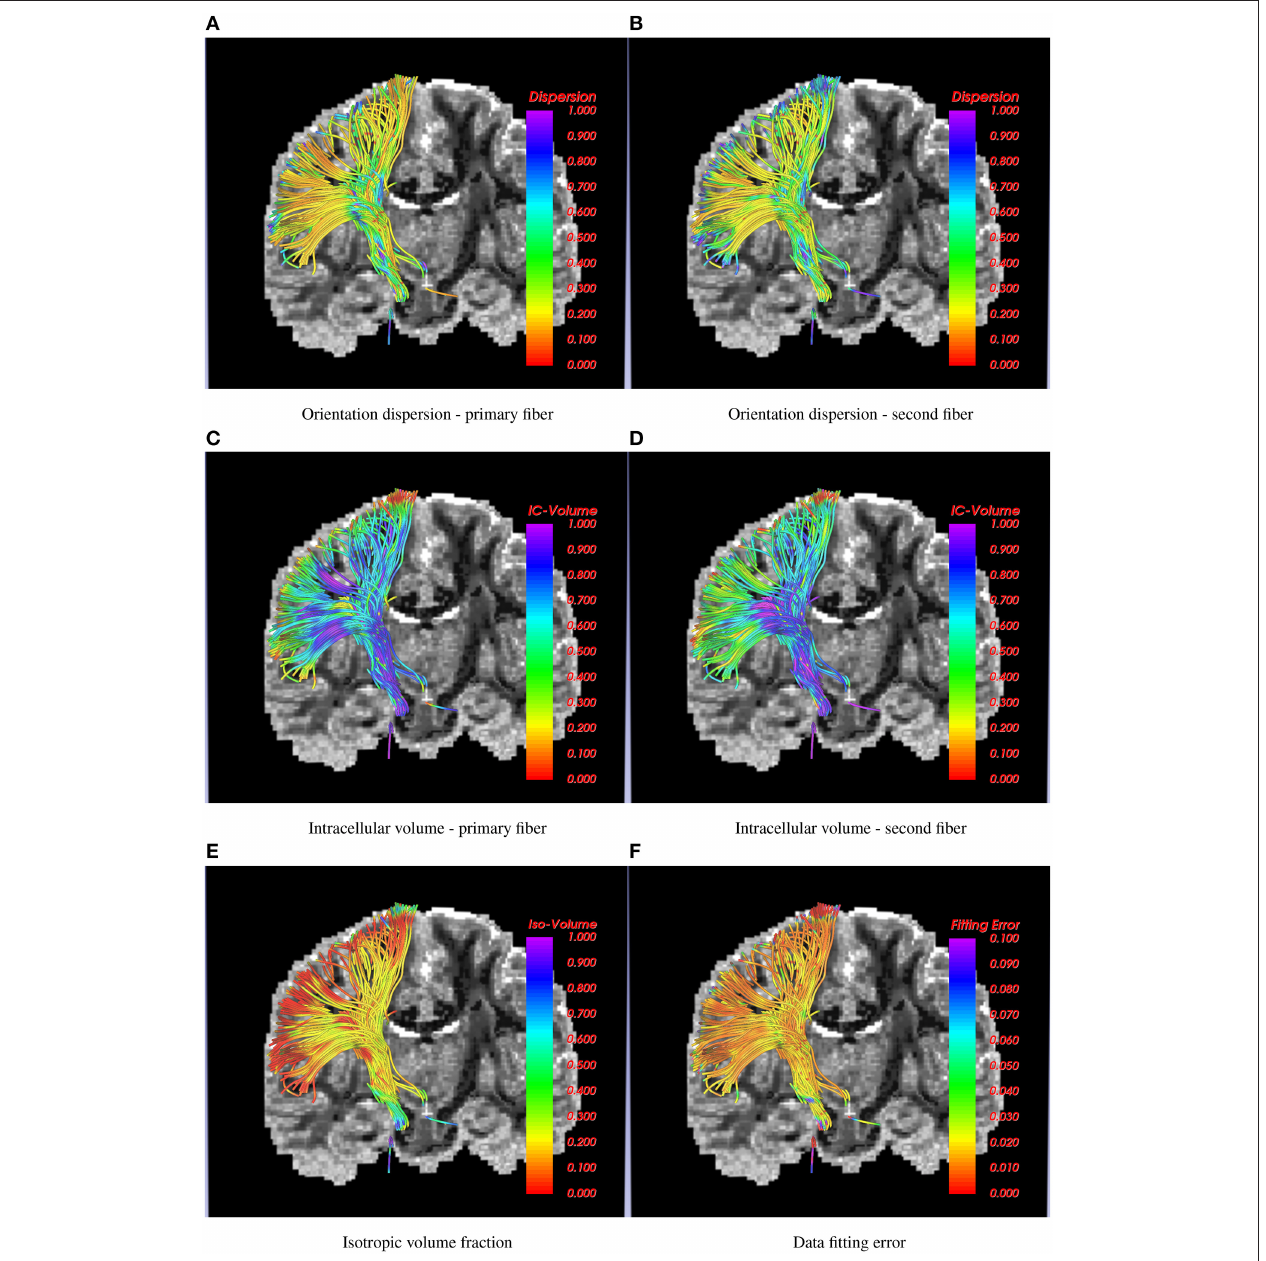
FIGURE 4 | Corticospinal tract traced using the 2-fiber NODDI model. In the background is a slice of orientation dispersion obtained from 1-fiber NODDI model of Daducci et al. (2015). Several NODDI specific measures are shown along the tracts along with the data fitting error, which is below 3% in most cases.